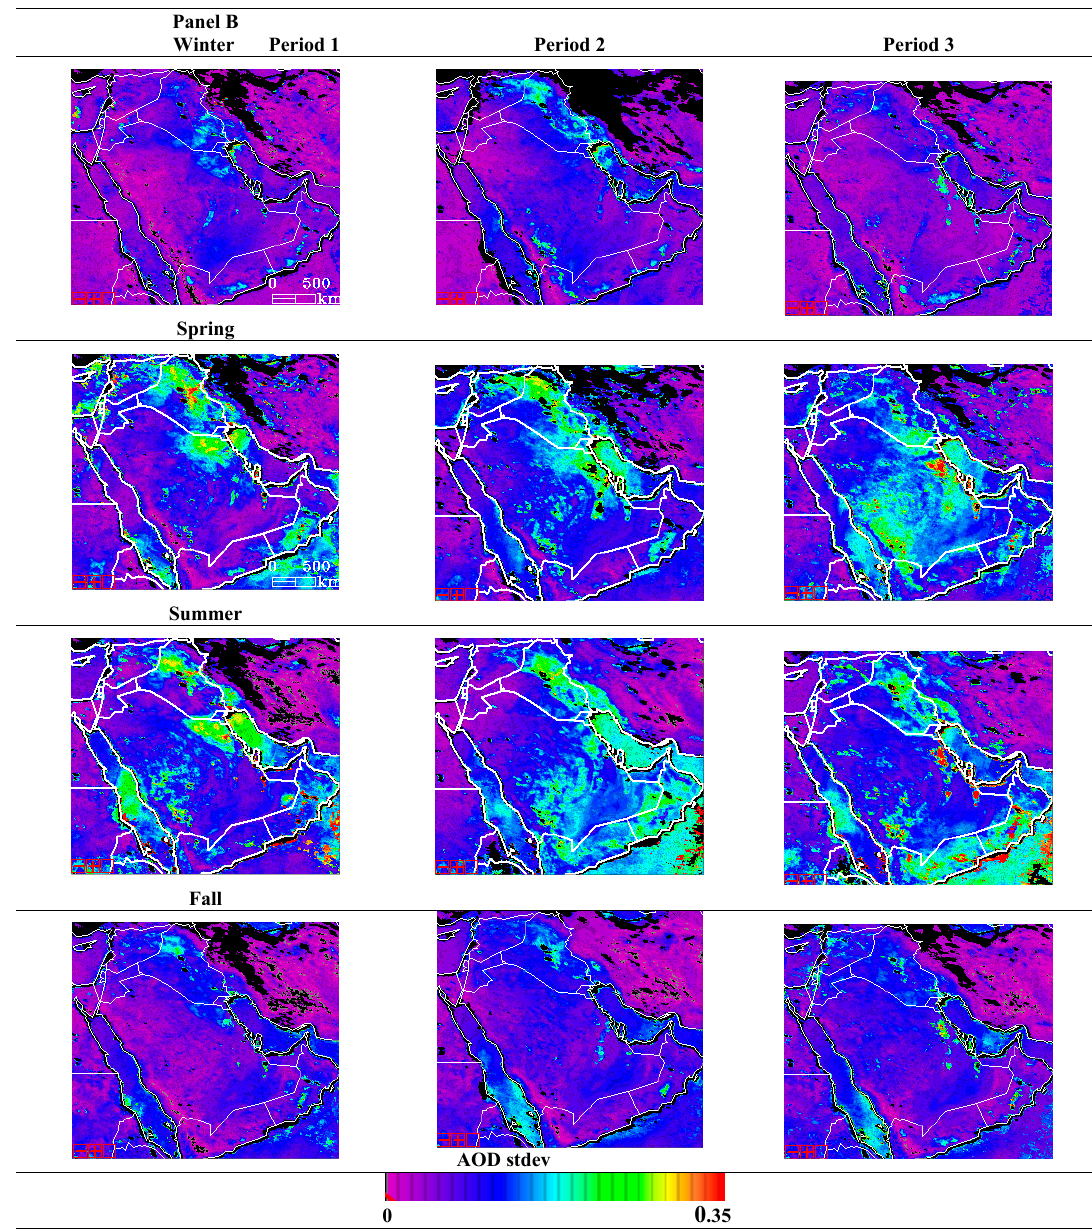
Figure 6. Averaged seasonal AOD (Panel A ) and AOD standard deviation (stdev) (Panel B ) on a pixel basis over three time periods: 1 March 2000–19 March 2003 (before entrance of US troops and coalition forces), 20 March 2003–31 December 2011 (US and coalition forces present), and 1 January 2012–31 December 2018 (‘post-war” period). Iraq, compared to all other countries in the region, had the largest AOD stdev during Period 2 for all seasons. We also noted areas of relatively high AOD stdev during Periods 1 and 3, but these